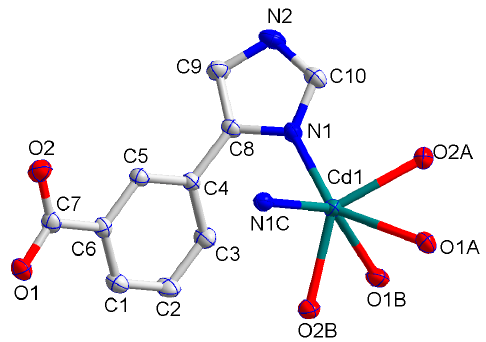
Figure 1. The coordination environment of Cd(II) ion in 1 with the ellipsoids drawn at the 30% probability level. The hydrogen atoms and free lattice water molecule are omitted for clarity. Symmetry code: A 0.5 + x, 0.5 + y, 0.5 − z, B 1.5 − x, 0.5 + y, z, C 2 − x, y, 0.5 − z.